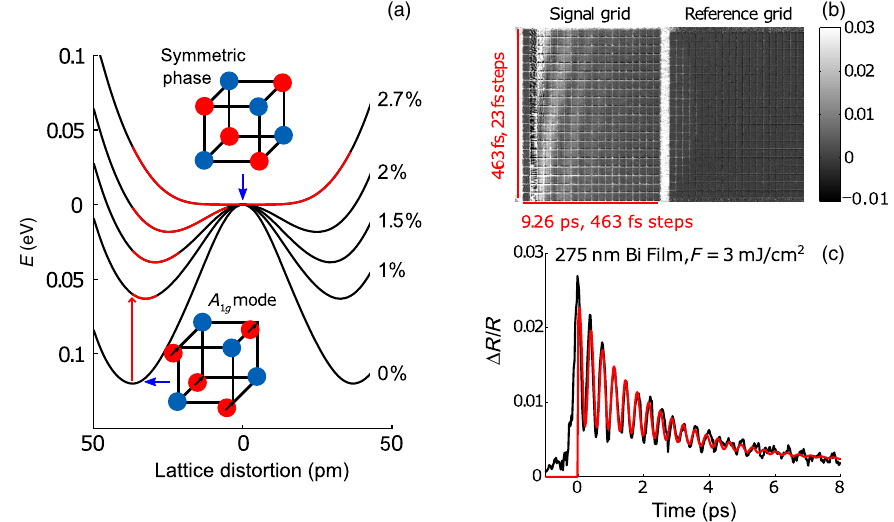
FIG. 1. Dual-echelon single-shot spectroscopy of bismuth. (a) Potential energy surface of bismuth along the A 1 mode coordinate at g various levels of electronic excitation. The range of coherent lattice motion upon fast excitation from the ground state is shown in red along the curves. At excitation densities above 2% of the valence electrons, the kinetic energy imparted to the A 1 mode is enough to g drive the central atom (shown in red in the schematic) across the center of the unit cell, forming the symmetric phase. The distorted (bottom) and symmetric (top) crystal structures are shown in (a), with arrows showing the direction of motion of the central atom (red). The lattice distortion is exaggerated for clarity. (b) Differential image of the echelon grid on a 275-nm-thick bismuth film, excited with a fluence of 3 mJ = cm 2 and a probe wavelength of 800 nm, on a scale of − 1% to 3% Δ R=R , showing coherent phonon oscillations on the signal (left) grid. This image is averaged over 50 laser shots. (c) Unfolded single-shot pump-probe trace extracted from the image in (b), showing coherent phonon oscillations of the A 1 mode. The red curve shows the fit to Eqs. (1) and g